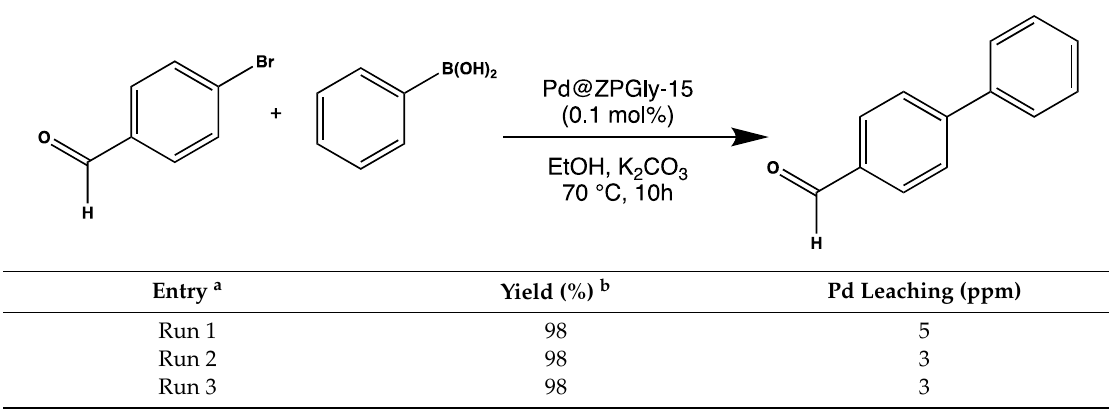
Table 5. Suzuki cross ‐ coupling reaction between 4 ‐ bromobenzaldehyde and phenylboric acid catalysed by Pd@ZPGly ‐ 15 (palladium nanoparticles on zirconium phosphate glycine diphosphonate nanosheets) catalyst [89].